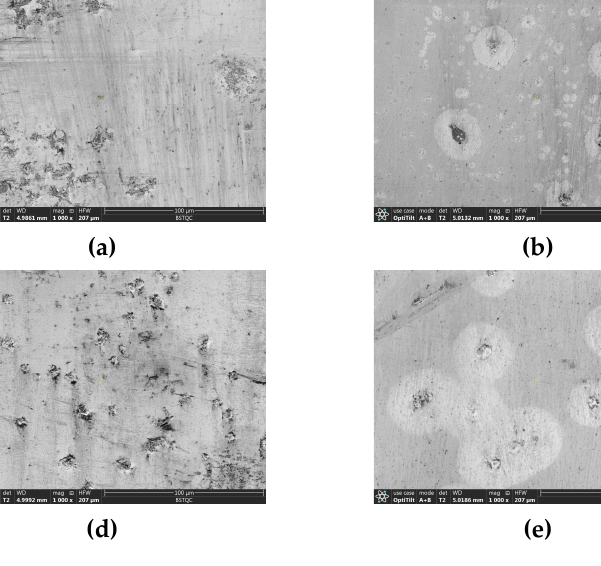
Figure 12. SEM images of the TFTC line. ( a ) The bottom of the TFTC left line; ( b ) The middle of the TFTC left line; ( c ) The top of the TFTC left line; ( d ) The bottom of the TFTC right line; ( e ) The middle of the TFTC right line; ( f ) The top of the TFTC right line.